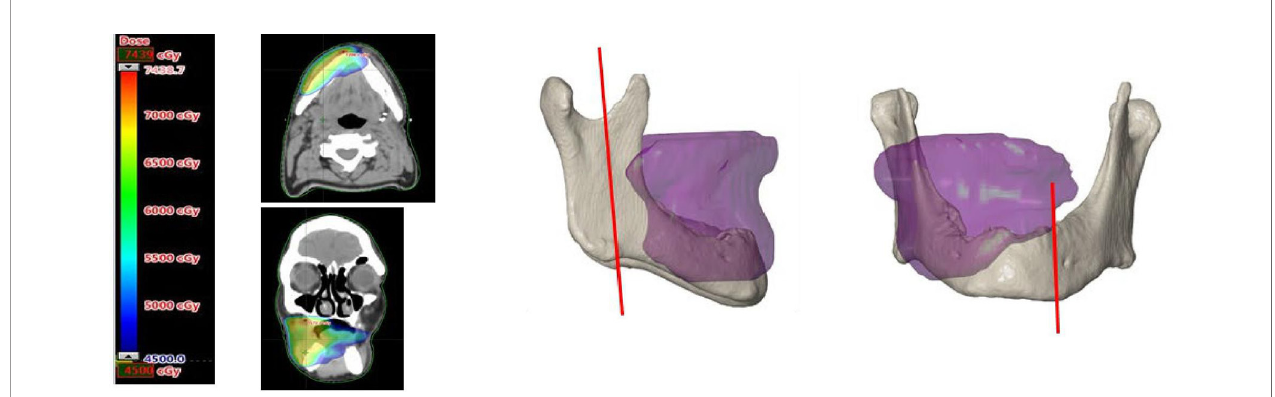
FIGURE 1 | On the left an axial and coronal CT image with superimposed the fi eld of view exposed to 50 Gy or more. On the right a 3D image of the superimposed 50 Gy fi eld on the 3D model of the mandible. The vertical red lines on the mandible mark the planned resection margins.